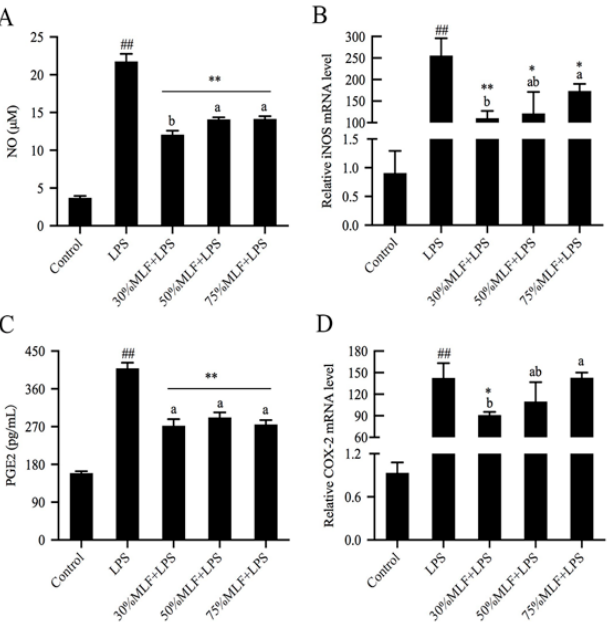
Figure 2. Effects of MLFs on ( A ) NO, ( B ) iNOS, ( C ) PGE2, and ( D ) COX-2 production in LPS-induced RAW 264.7 cells. Columns with different superscript letters are significantly different ( p < 0.05); * p < 0.05 and ** p < 0.01 vs. the LPS group; ## p < 0.01 vs. the control group.